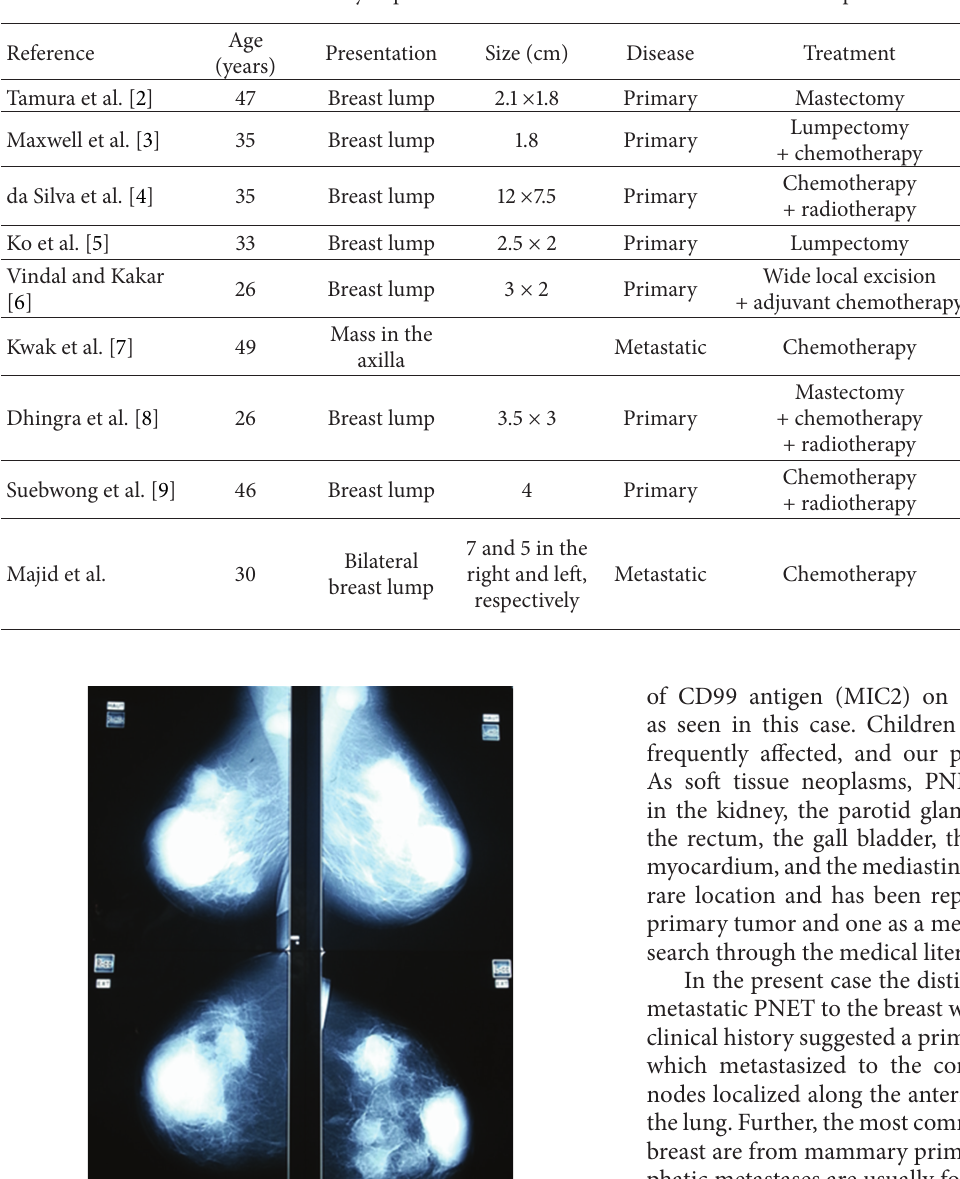
Table 1: Summary of primitive neuroectodermal tumors of the breast reported in the literature.